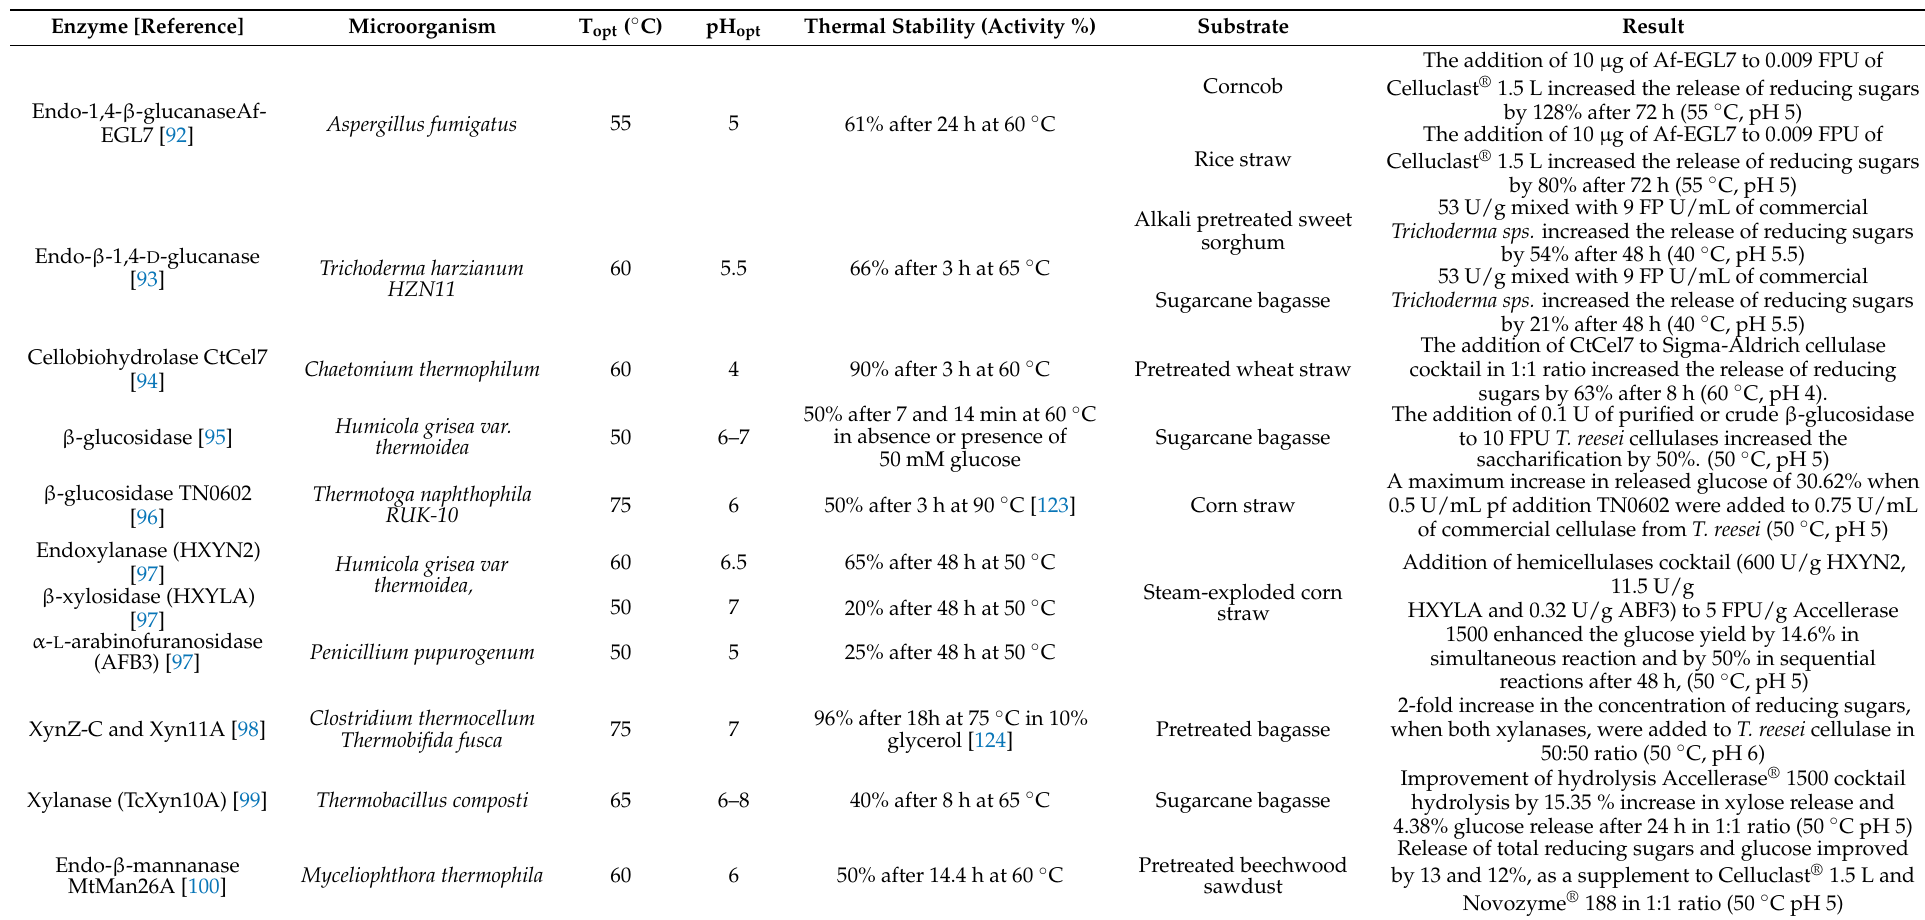
Table 1. Examples of thermophilic enzymes implementation in commercial cellulolytic enzyme